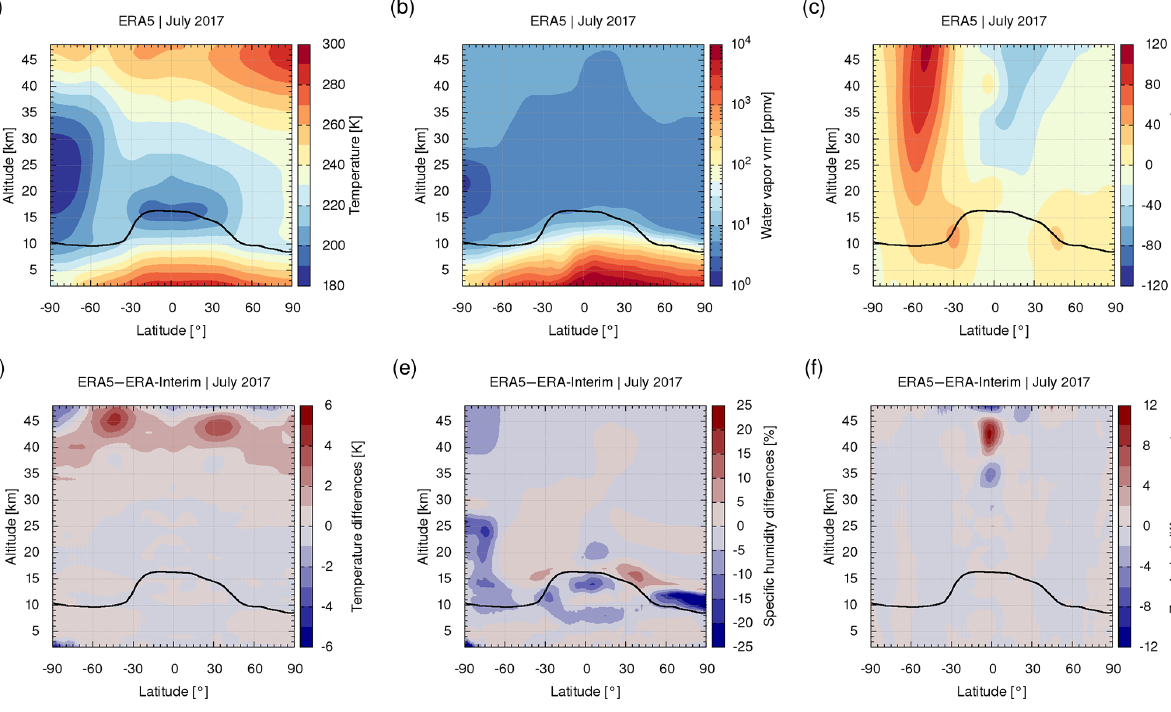
Figure 4. Same as Fig. 3, but for July